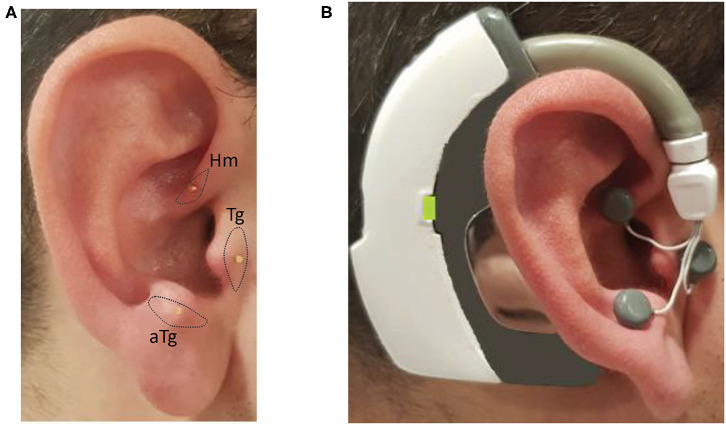
Photos of the inserted needles over the intrinsic auricular muscle zones and the electrical stimulation device worn on the ear with the electrodes attached to needles: (A) inserted needles on the intrinsic auricular muscle zones; and (B) electrical stimulation device is worn and electrodes attached to needles on the ear.